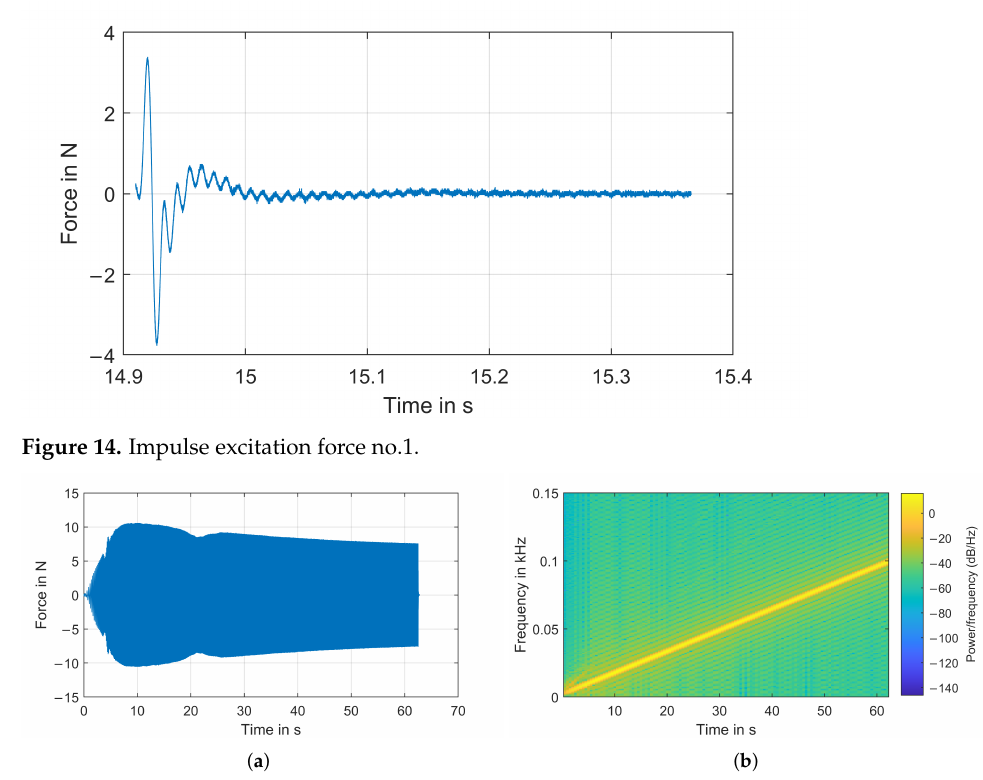
Figure 15. ( a ) Time-domain signal and ( b ) spectrogram of sweep